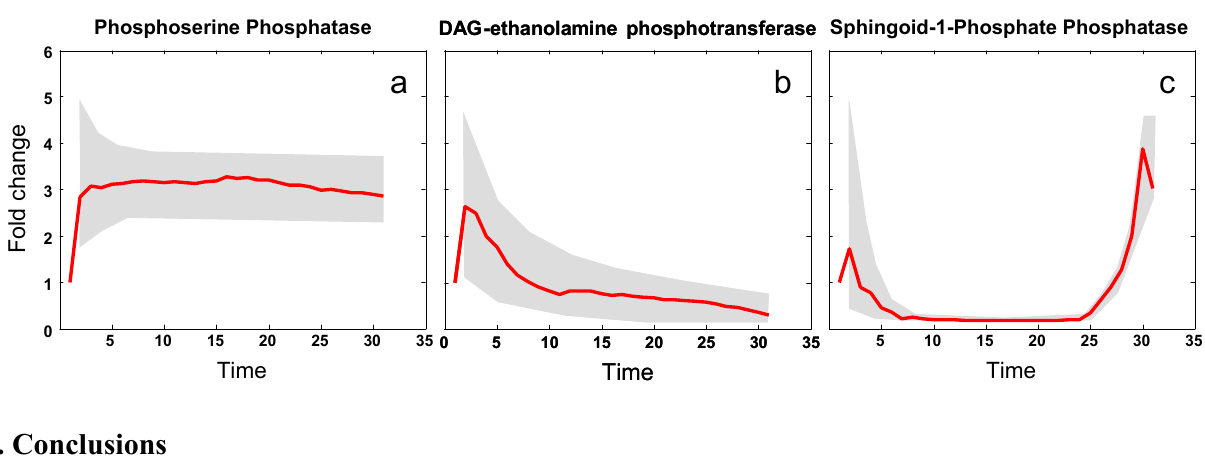
Figure 5. Examples of three classes of heat-induced changes in enzyme activities within sphingolipid metabolism. Heat stress causes the activities of: phosphoserine phosphatase to increase ( a ); diacylglycerol (DAG) ethanolamine phosphotransferase to decrease ( b ); and sphingoid-1-phosphate phosphatase to decrease initially and subsequently to increase substantially, presumably due to gene expression that begins to increase as soon as the temperature rises ( c ). Grey bands indicate ranges of responses, while red lines show average